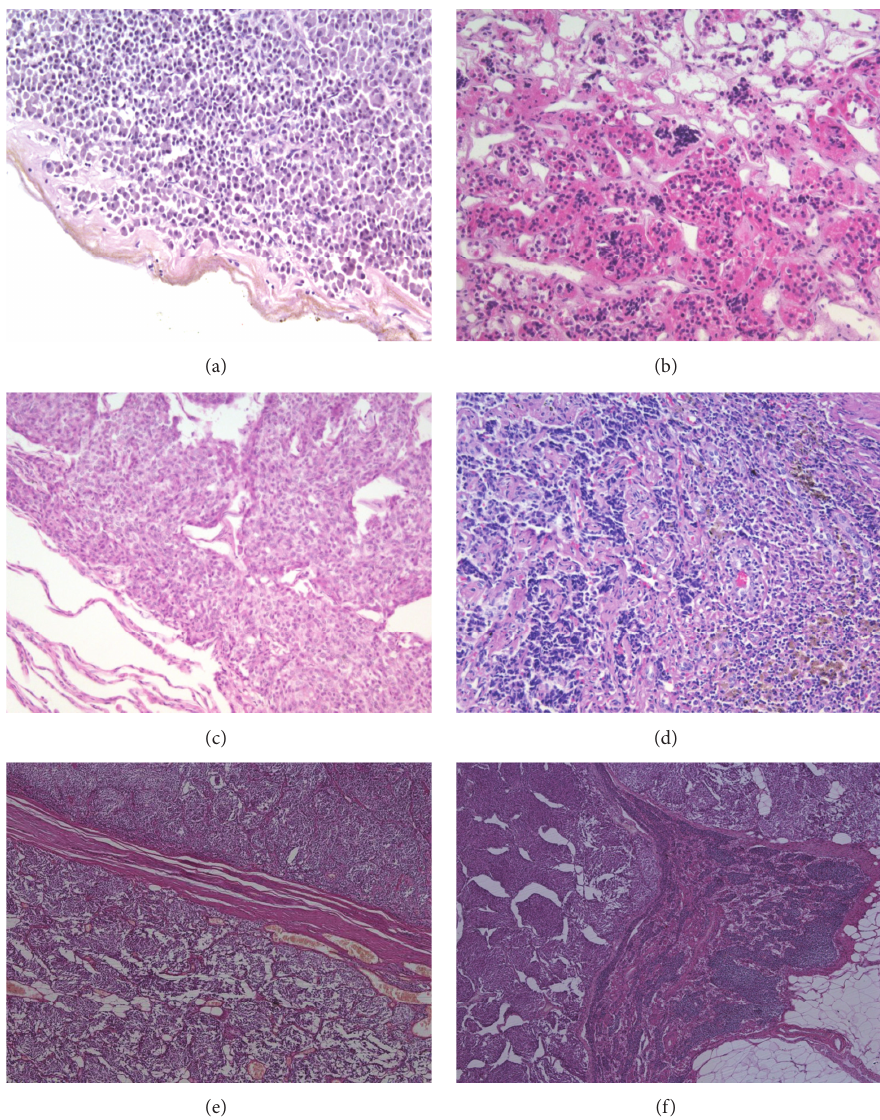
Figure 4: Histological structure of corticotropinomas and ectopic ACTH-secreting tumours (hematoxylin and eosin stainings). (a) A fragment of basophilic corticotropinoma, × 20. (b) Oxyphilic cell hyperplasia in adenohypophysis, × 20. (c) Typical lung carcinoid, × 20. (d) Metastasis of atypical lung carcinoid to a mediastinal lymph node, × 10. (e) and (f) Appendiceal NET (G2), × 10, 25 mm in diameter, clinically manifested as cyclic Cushing’s syndrome with carcinoid crisis attacks between hypercortisolism cycles. (e) Invasion of the tumour into mesenteric fat. (f) NET metastasis to a mesenteric lymph